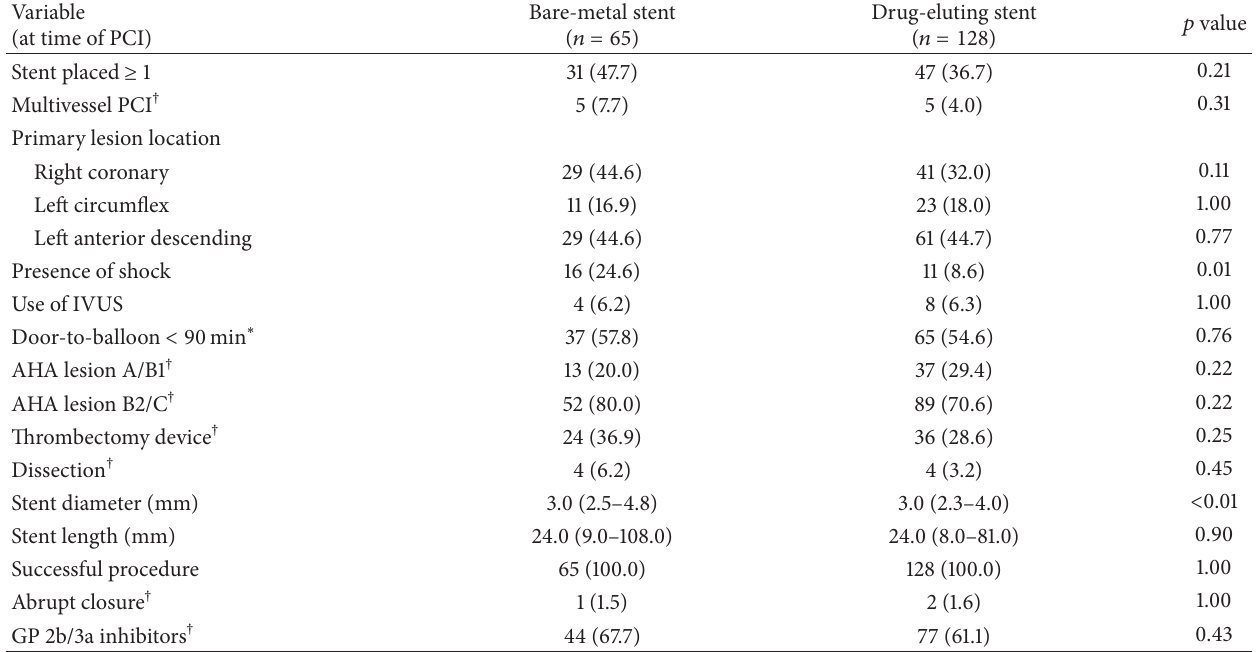
Table 2: Association of procedural characteristics for use in primary PCI for